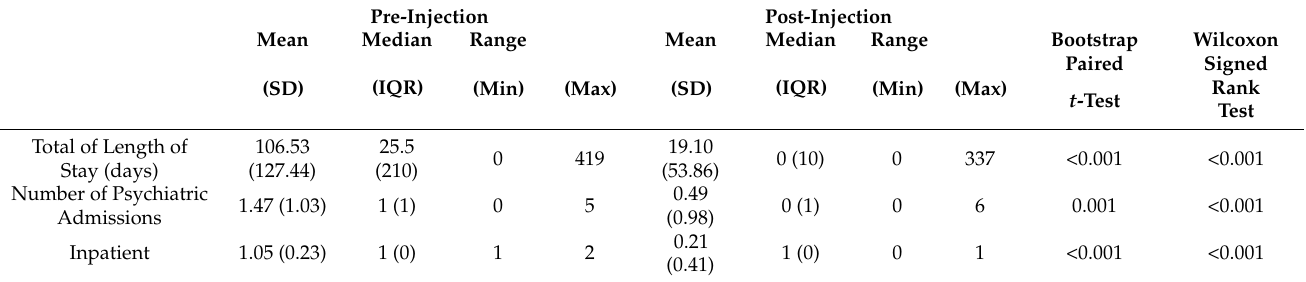
Table 2. Hospital utilization before and after PP1M injection initiation among everyone ( n = 158): inpatient ( n = 57) and outpatient ( n =